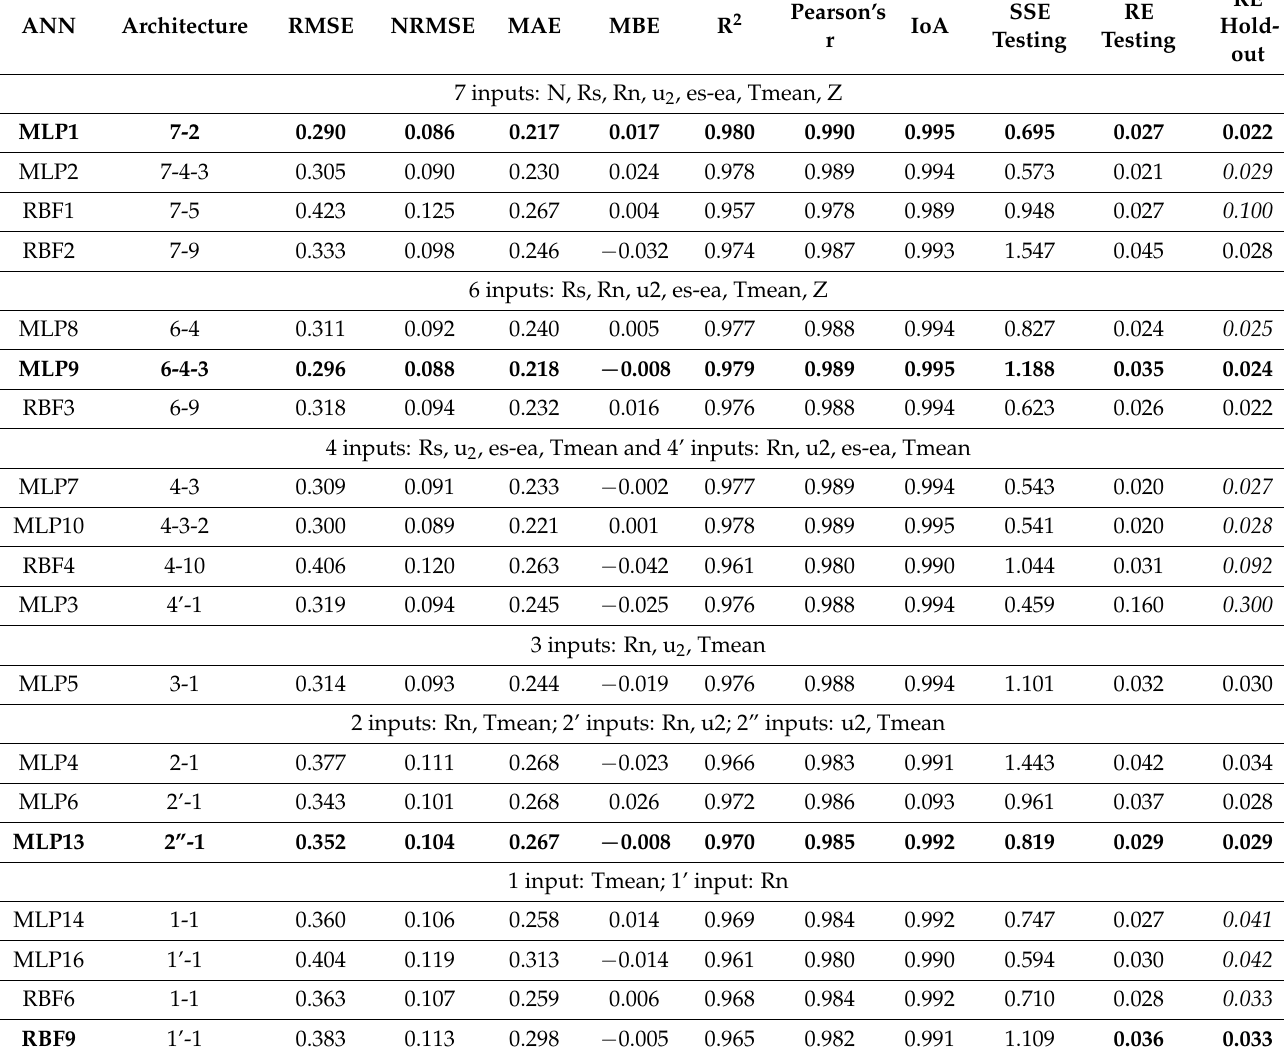
Table 2. The examined ANN models (19) and the corresponding indices of performance.